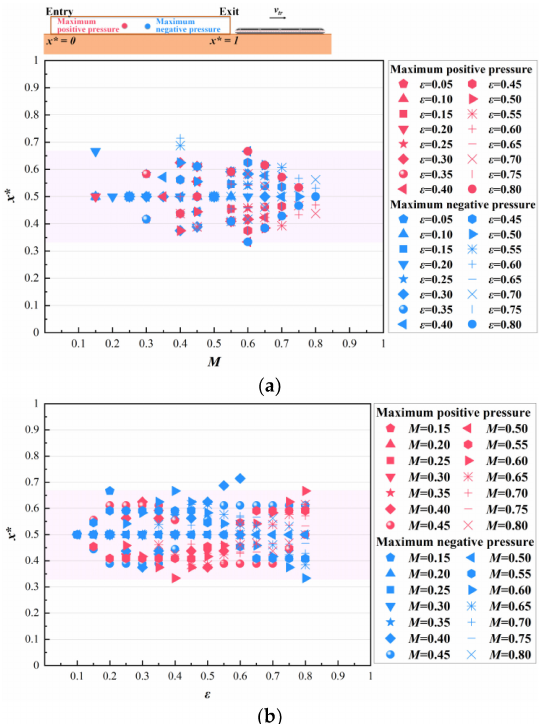
Figure 8. Distribution of the normalized location of the extreme pressure under different conditions ( M ≤ 0.8, ε ≤ 0.8): ( a ) from the point of the train/wave velocity ratio M ; and ( b ) from the point of the train/tunnel length ratio ε .